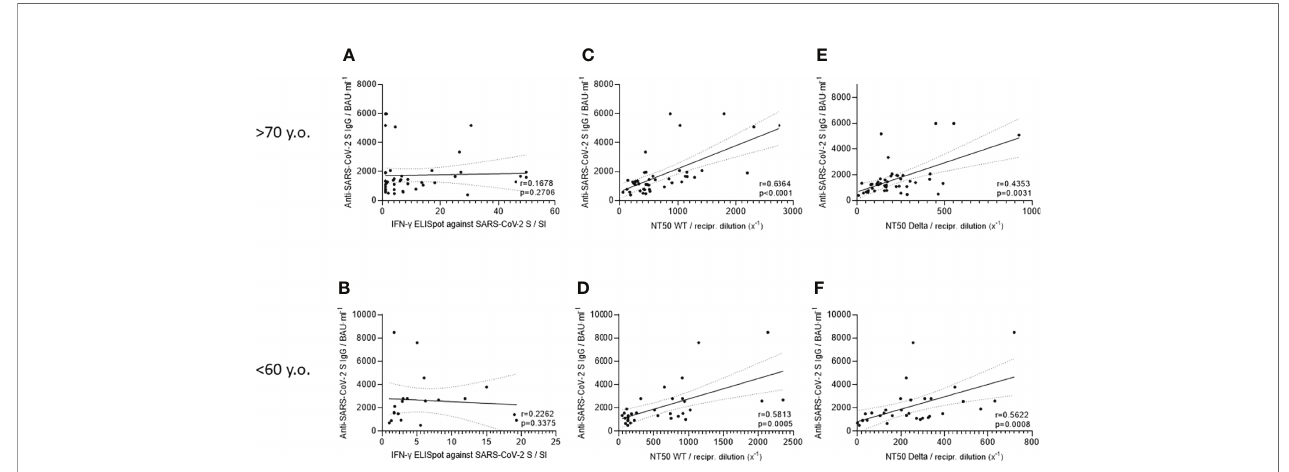
FIGURE 5 | Correlation of T cell response against SARS-CoV-2 spike, anti-SARS-CoV-2 S IgG titer and NT50 values against WT and Delta variant for participants younger than 60 years or older than 70 years. Dependencies between T cell response against SARS-CoV-2 spike, SARS-CoV-2-speci fi c IgG, and NT50 values from SARS-CoV-2 WT and Delta virus were calculated by nonparametric Spearman correlation analysis. Correlations for participants older than 70 years were visualized as (A) T cell response (IFN g ELISpots) vs. IgG (n = 45), (C) IgG response vs. NT50 values against WT virus (n = 45) and (E) IgG vs. NT50 against Delta variant (n = 45). To improve visualization of the trend, a linear regression with a 95% con fi dence interval (CI) was plotted. SARS-CoV-2-speci fi c T cells (IFN g ELISpots) are presented as Stimulation Index (SI), IgG titers in binding antibody units per ml of serum (BAU·ml − 1 ) and NT50 values as a dilution factor for serum (1:x). The same correlations were determined for people younger than 60 years (B) (n = 20), (D) (n = 32), and (F) (n =